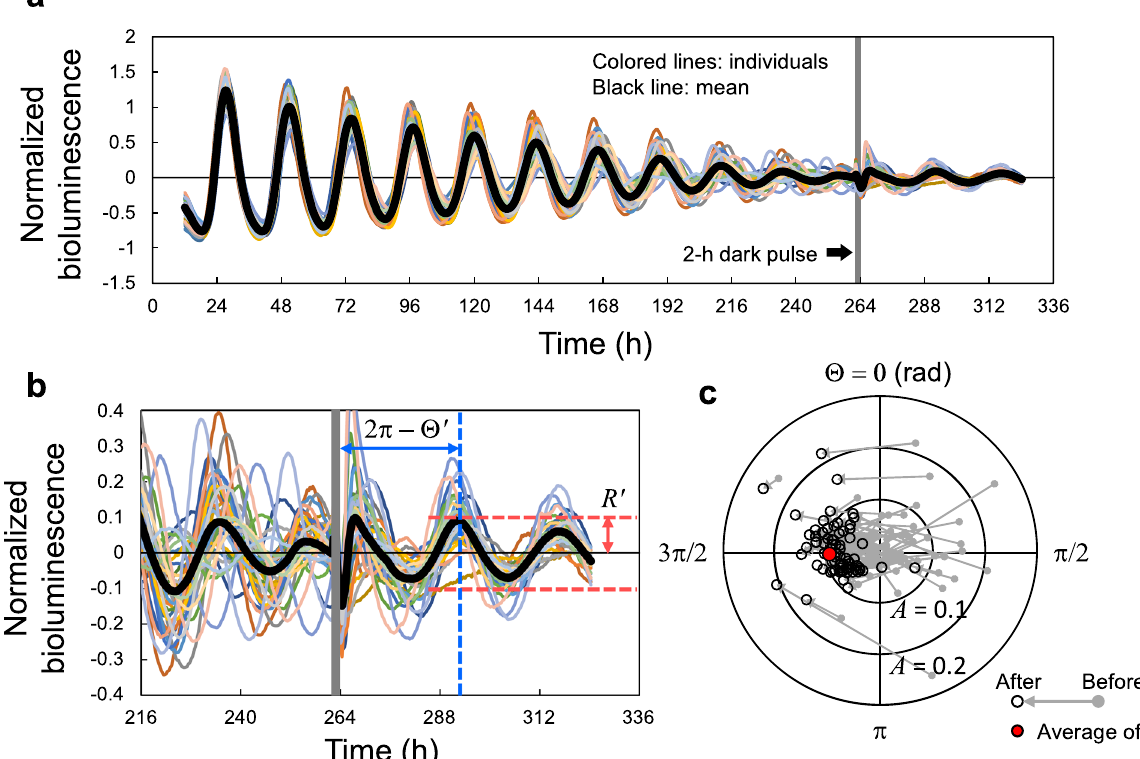
Fig. 1 Reset of circadian rhythm at singularity state. a , b Normalized bioluminescence of CCA1 :: LUC in continuous light ( n = 36 individuals). The black line represents mean bioluminescence; the gray bar represents the single 2-h dark pulse. c Phase Θ and amplitude A before (gray dot) and after (black circle) pulse. Each arrow represents an individual. The red dot indicates the center of gravity of points after the pulse.